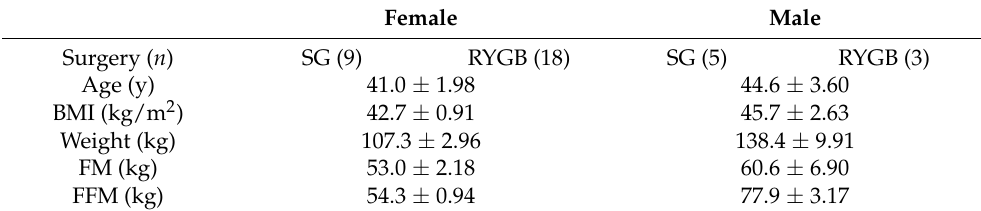
Table 1. Main anthropometric characteristics of subjects at baseline before bariatric